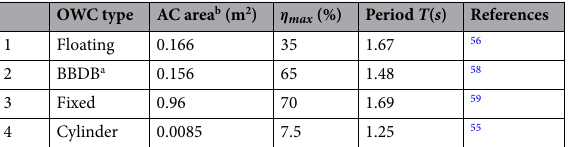
Table 2. Primary conversion efficiency for different OWCs. a Backward Bent Duct Buoy b Sectional area of the air